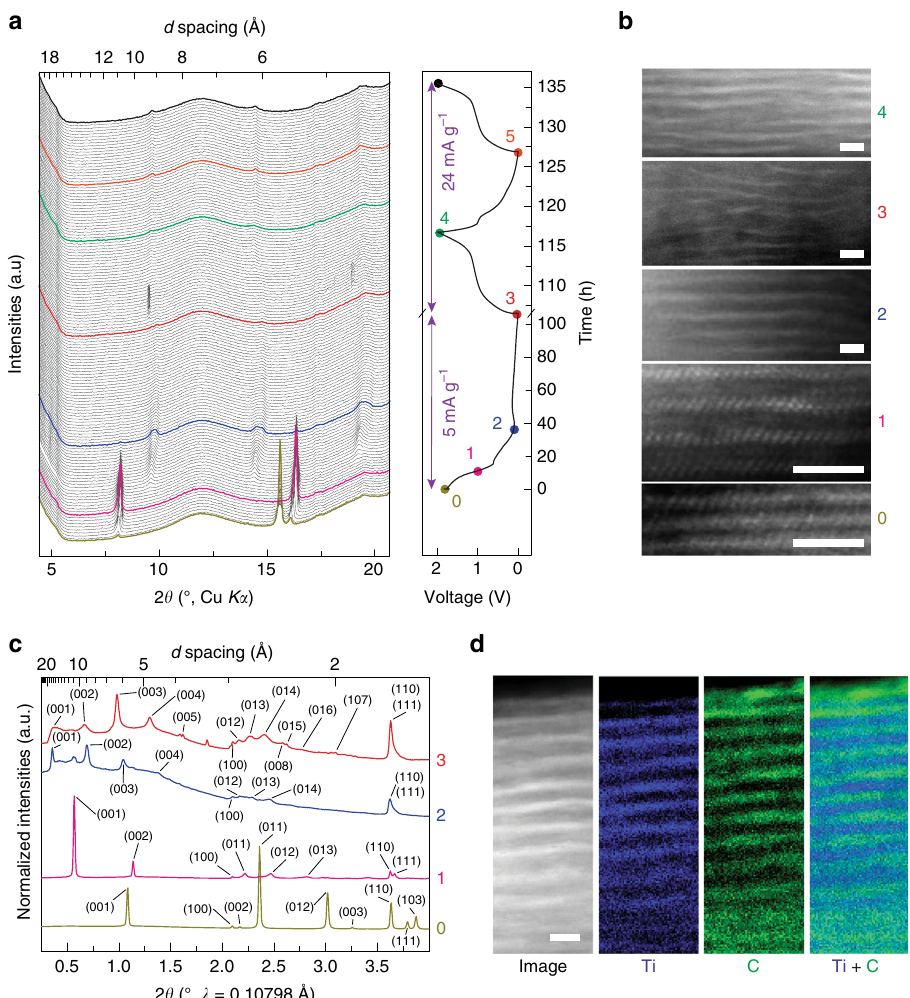
Fig. 3 Structural characterizations of TiS 2 during the initial activation. a In operando XRD characterization and corresponding galvanostatic voltage pro fi le for the fi rst two cycles. b STEM images for stages 0 to 4. c HE-XRD patterns for stages 0 to 3. d The STEM image and the elemental mapping of Ti and C at stage 4. Scale bars: 2 (Supplementary Table 3). Electron energy loss spectroscopy (EELS) also evidences Mg and Cl L 2,3 peaks for stage 3, whereas the peaks are absent at stage 4 (Fig. 4c). Both discharged and charged electrodes (stages 3 and 4, respectively) contain ~1 at.%